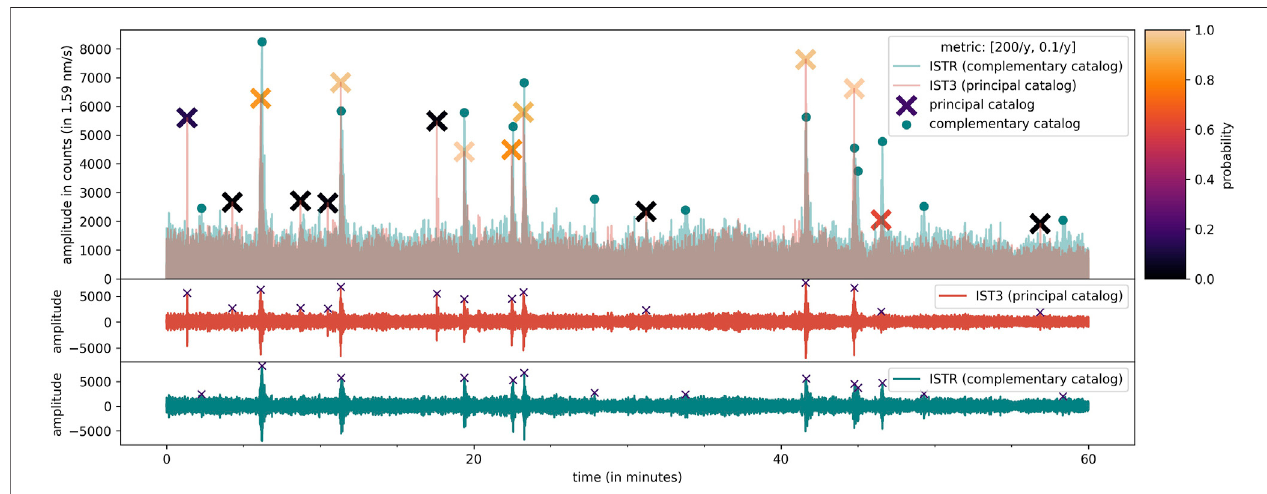
FIGURE 6 | Catalog consolidation test. Seismo-volcanic events that only appear at one of the two stations are assigned a small probability (that the source of the signal is the volcano). Events that match in both catalogs have a probability close to 1.